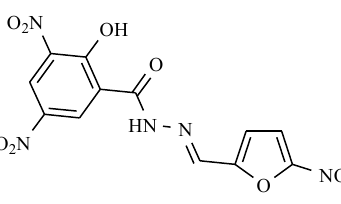
Figure 18. Nifursol as anti-trypanosomiasis drug.